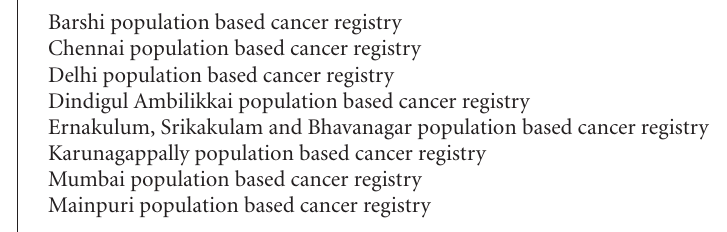
Box 1: List of cancer registries reporting incidence of oral